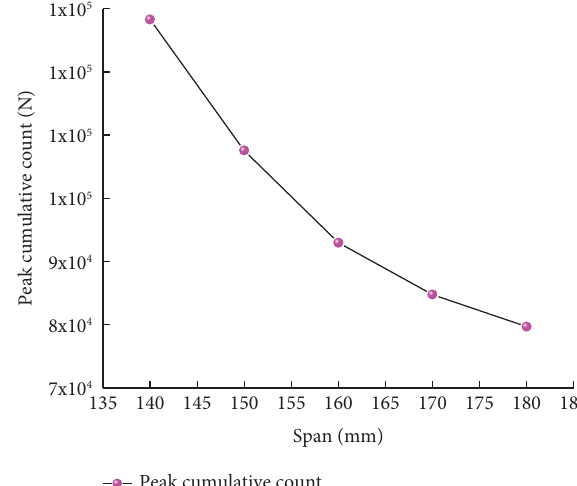
Figure 5: Cumulative ringing count curve of acoustic emission in diferent